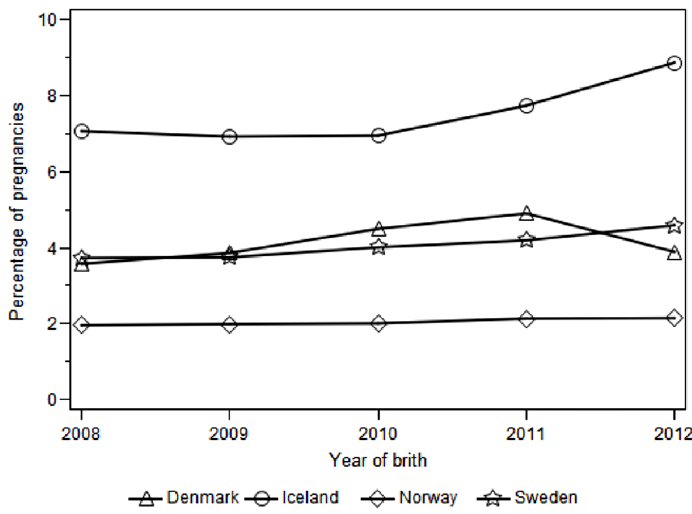
doi:10.1371/journal.pone.0144474.g001